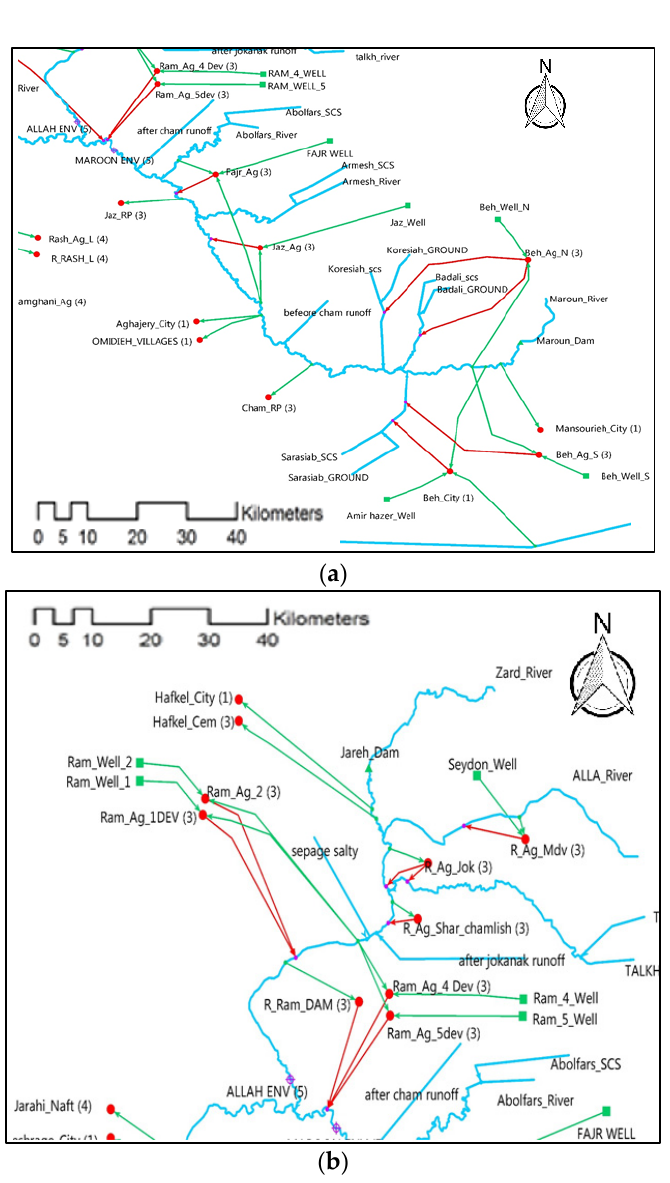
Figure 6. Model configuration for the boundary conditions: ( a ) Maroon; and ( b ) Jarahi.